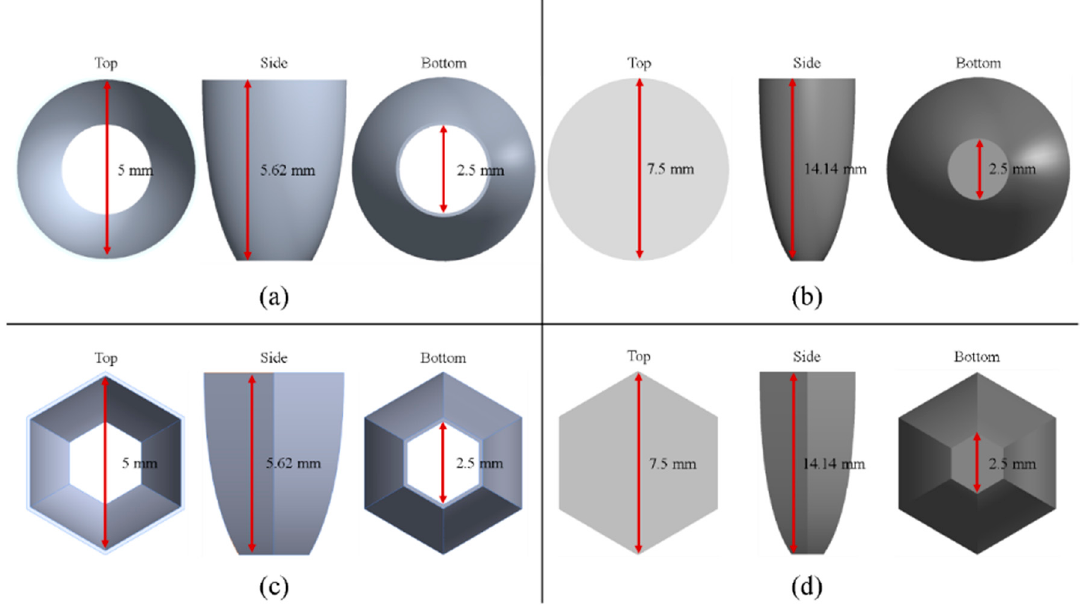
Figure 11. The parameters and appearances of the ( a ) mirror-CPC, ( b ) solid-CPC, ( c ) mirror-NACPC, and ( d ) solid-NACPC.